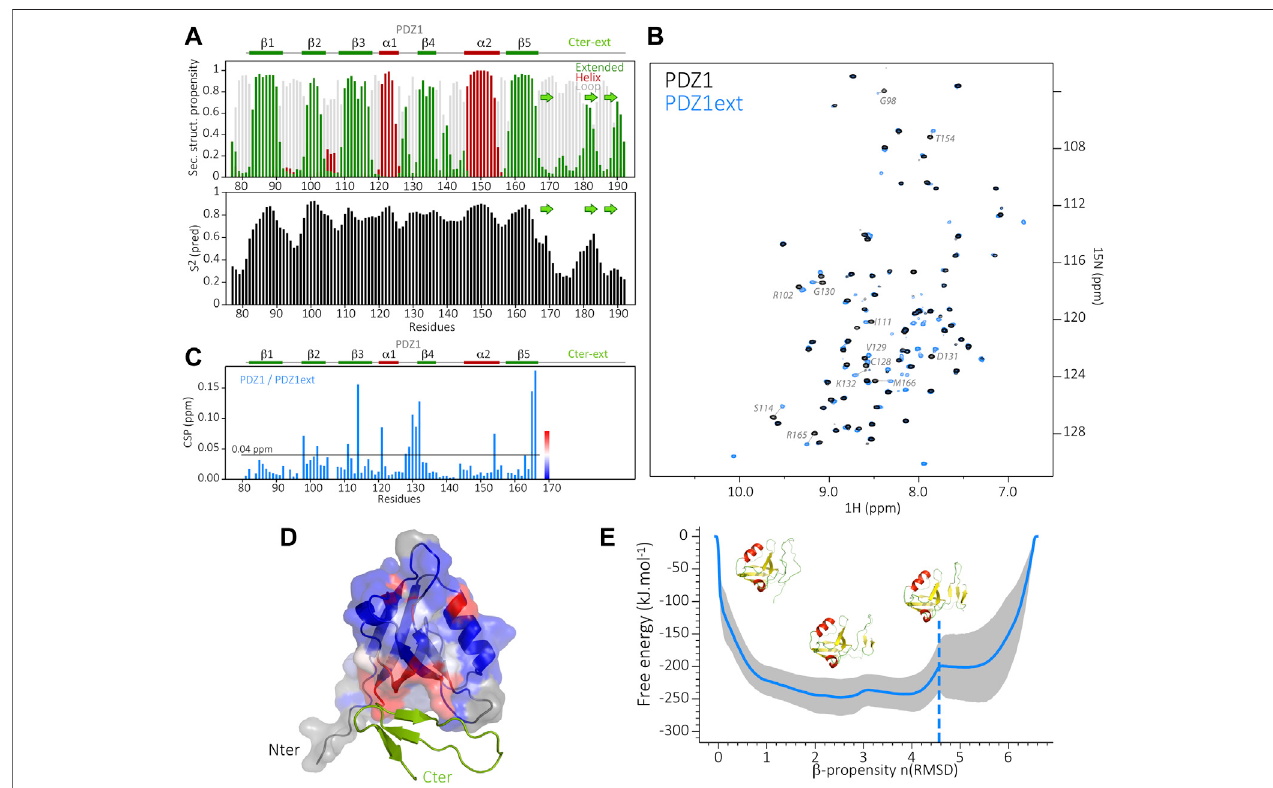
FIGURE2|(A) Secondarystructure prediction fromTALOS-N,basedonthebackboneassignmentofPDZ1ext, showing thepropensity of β -strands ingreenand α -helices in dark red (at the top) and the predicted order parameters S 2 (at the bottom). In the Cter extension, the consensus position of the three b-strands (green arrows) isinferred fromtheTALOSorder parameters and theAlphaFold predicted model. (B) Superimposed 1 H- 15 NHSQCspectraofPDZ1 (black)andPDZ1ext (blue). Assignment is indicated in gray for the most perturbed PDZ1 residues (CSP > 0.04 ppm). Blue peaks without assignment correspond to residues of the Cter extension. (C) NMR chemical shift perturbations (CSP) on PDZ1 induced by the Cter extension, i.e. , between PDZ1 and PDZ1ext. Secondary structure elements are indicated at the top. (D) Structure of PDZ1ext AlphaFold model in ribbon, with the PDZ1 domain displayed as surface and the Cter extension in green. CSP induced by the Cter extension are mapped on the AlphaFold model of PDZ1ext. The color coding from blue (no CSP) to red (large CSP) as indicated in (C) highlights the packing of the Cter extension onto PDZ1, in agreement with the AlphaFold model. Residues depicted in grey have no associated chemical shift (missing peak in PDZ1ext). (E) Energy landscape obtained by metadynamics computing. The blue line indicates the average energy measured for each β propensity across four trajectories. Standard deviation is indicated by the grey outline. Displayed snapshots correspond to conformations extracted from the trajectory. The vertical dashed line indicates the starting point of the